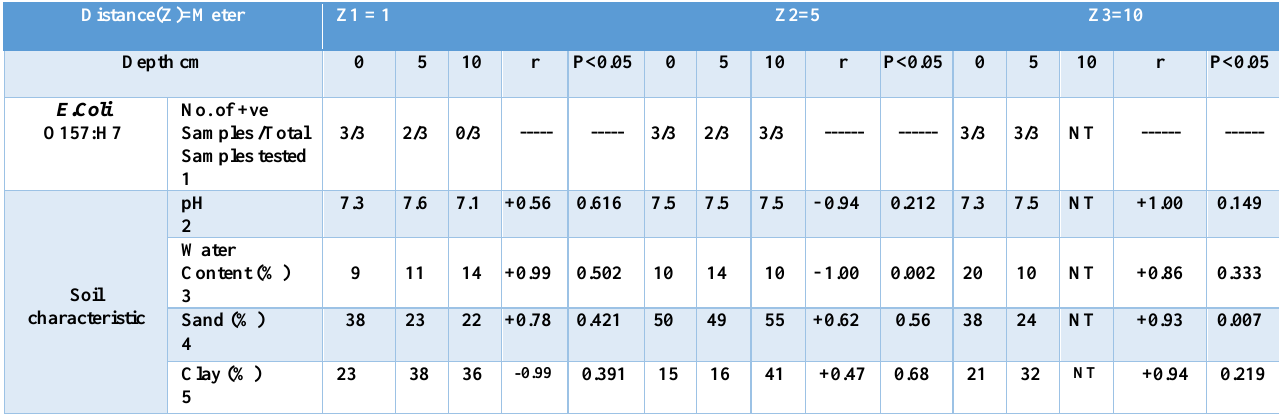
Table, 5: Correlation (r) between the prevalence of E.Coli O157:H7 and physico-chemical characteristics of the soil at the right (R) side of the dairy farm.